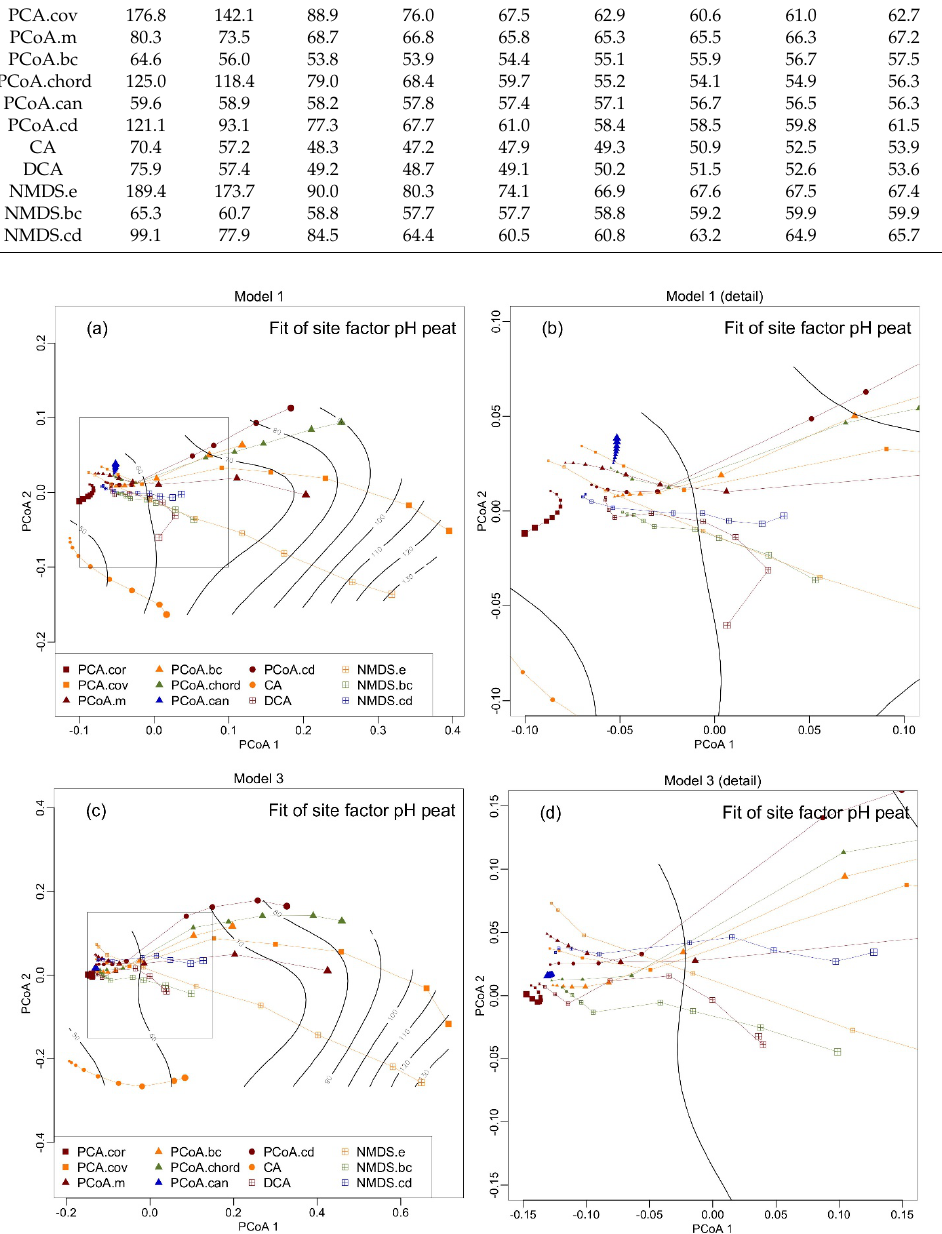
Figure 2. An ordination of the ordinations based on Mantel distance ( a , b ) and, alternatively, sum of squared differences obtained in procrustean analysis ( c , d ). Symbol size corresponds with the transformations shown in Figure 1. Light lines are connecting identical methods. Panels ( b , d ) are enlargements of the area highlighted in panels ( a ) and ( c ), respectively. Isoclines show the fit of site factor “pH.peat” (a variable in data frame “ssit”) to the individual ordinations derived from the vegetation data frame